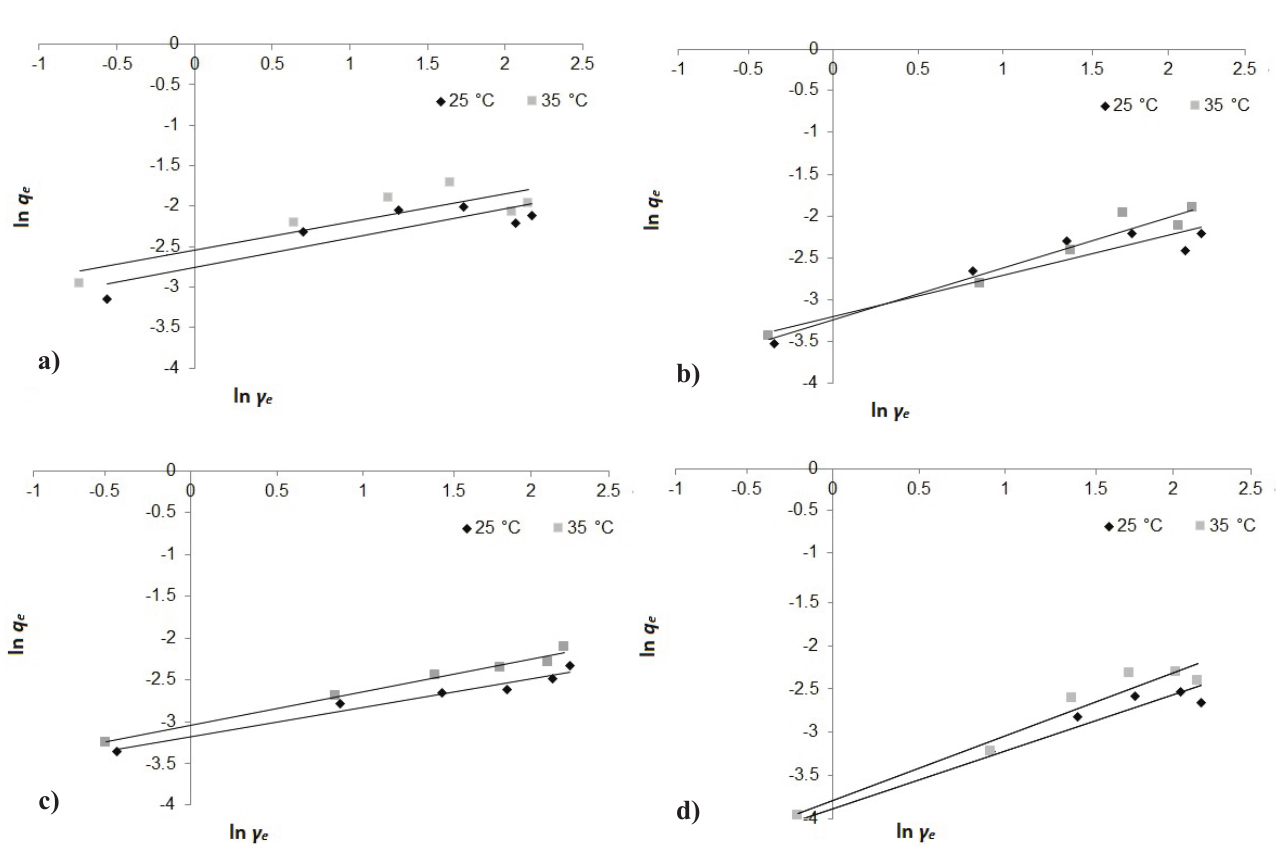
Fig. 7 – Freundlich isotherms for HA adsorption on (a) Cm1, (b) Cm2, (c) Hm1, and (d) Hm2 (γ V = 100 mL, pH = 7, t = 120 min, 120 solution